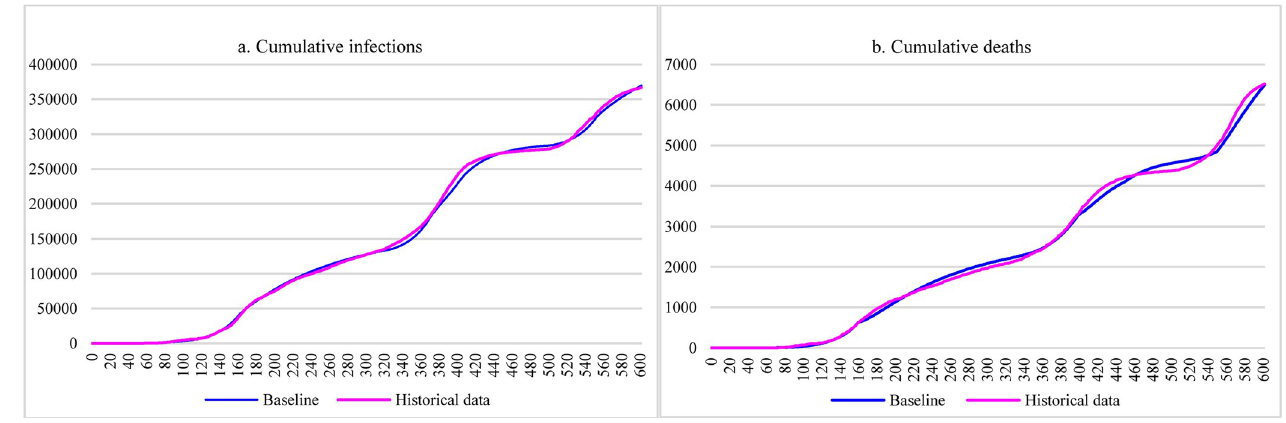
Fig 3. Baseline results by calibrating the model against historical data.